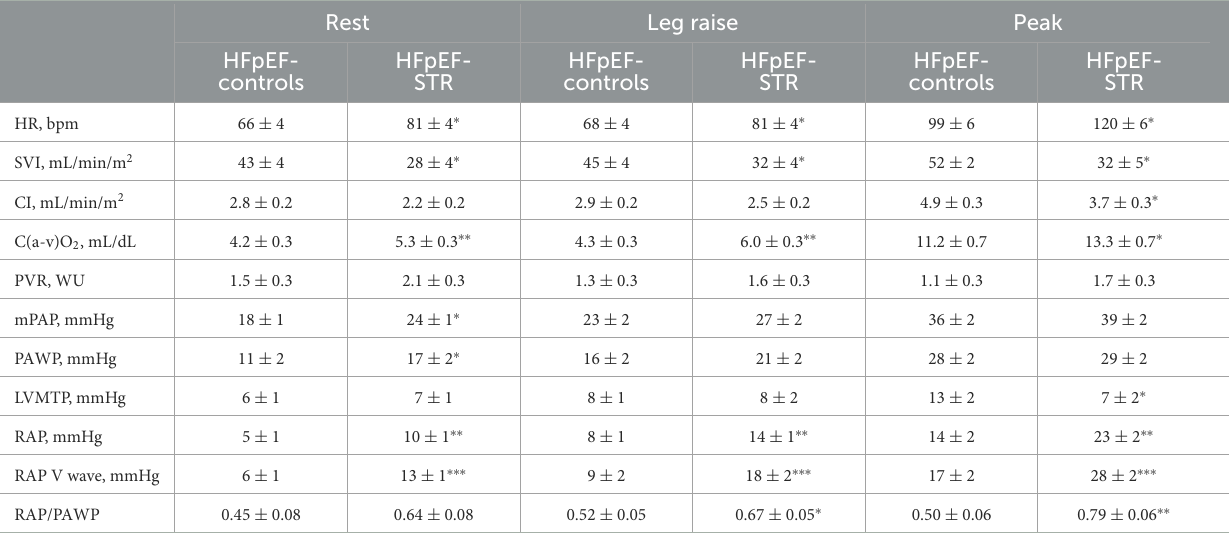
TABLE 2 Hemodynamics at rest, with feet on the pedals and at peak exercise in the study cohort.